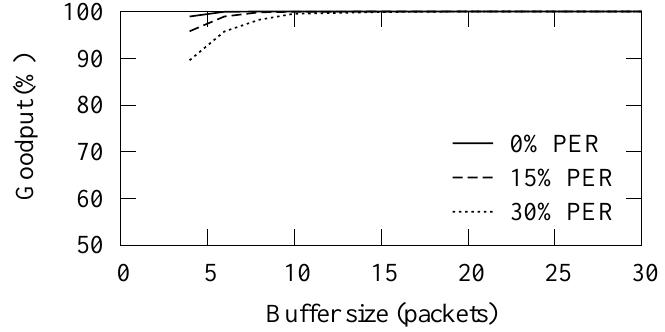
Figure 23. The effect of buffer size to the reliability in ZigBee using the reliable data for- warding algorithm (12 sources, 15 B/s offered